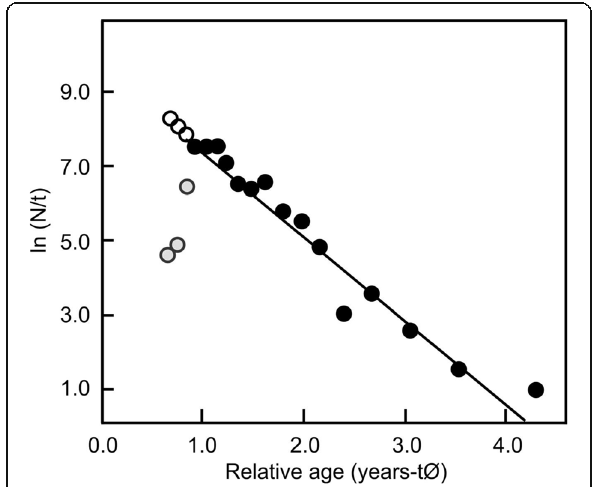
Fig. 3 Length-converted catch curve for Pachypterus khavalchor from